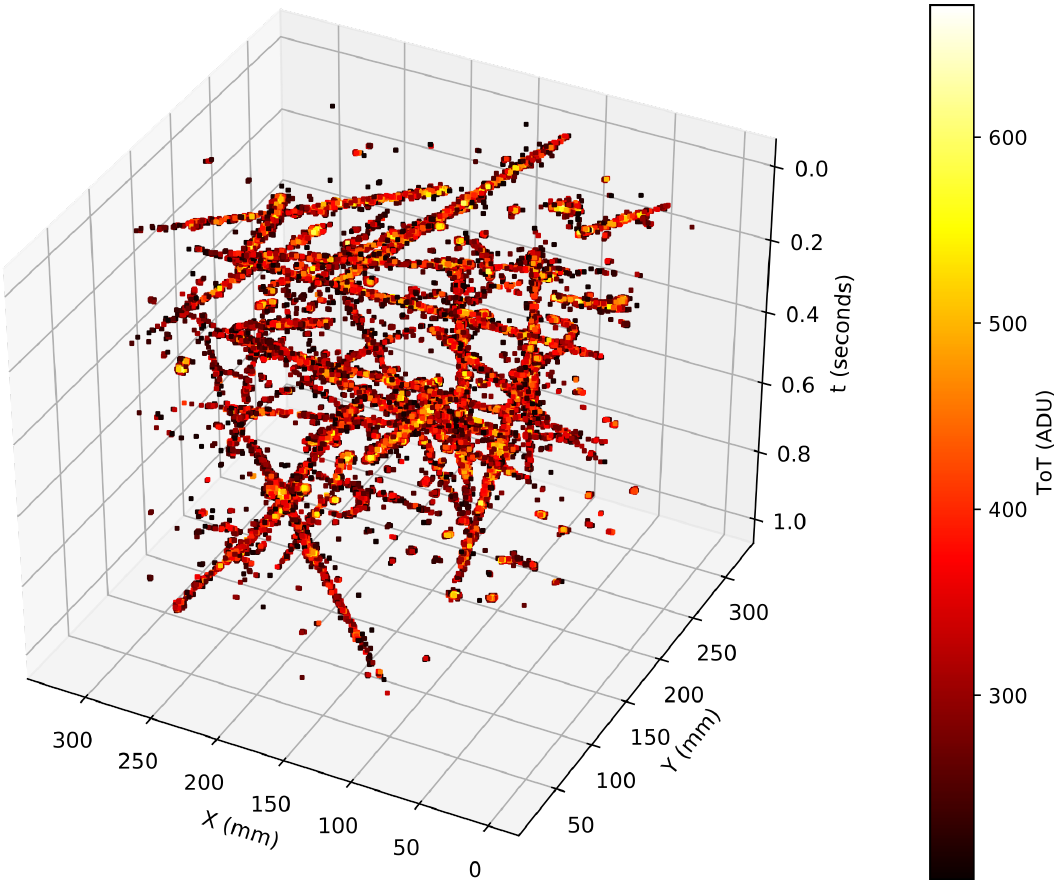
Figure 8. A 1 second long slice of the TPX3Cam’s continuous output data stream, showing numerous LAr interactions of cosmic muons and corresponding to an effective drift length of 1.608 km. The colour bar indicates the individual hit ToT values in